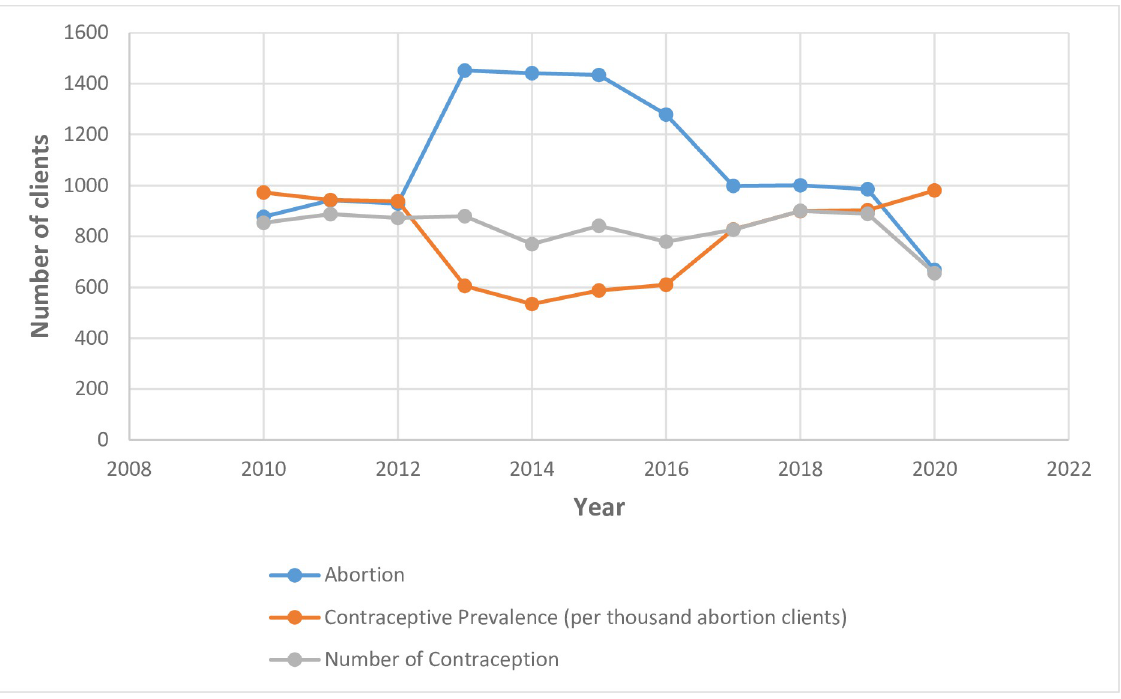
Fig 4. Trends in the number of clients who had induced abortion, number of clients who had contraceptive uptake and the prevalence of contraceptive uptake per thousand abortion cases.